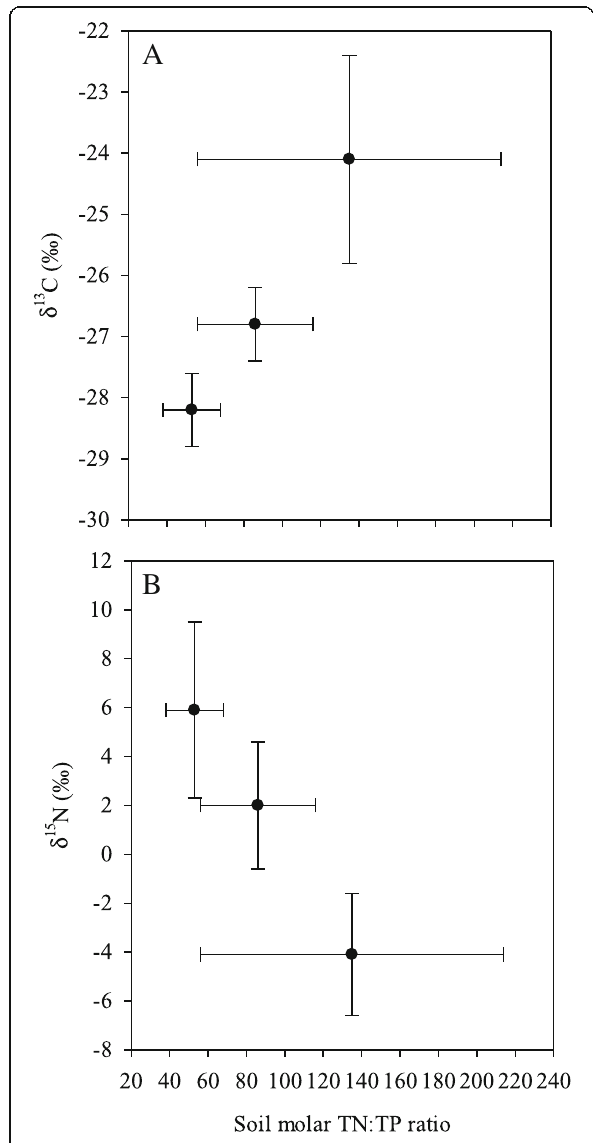
Fig. 3 Changes in cattail δ 13 C ( a ) and δ 15 N ( b ) and soil total nitrogen (TN):total phosphorus (TP) ratios (mean ± SD) measured along the nutrient gradient in south Florida